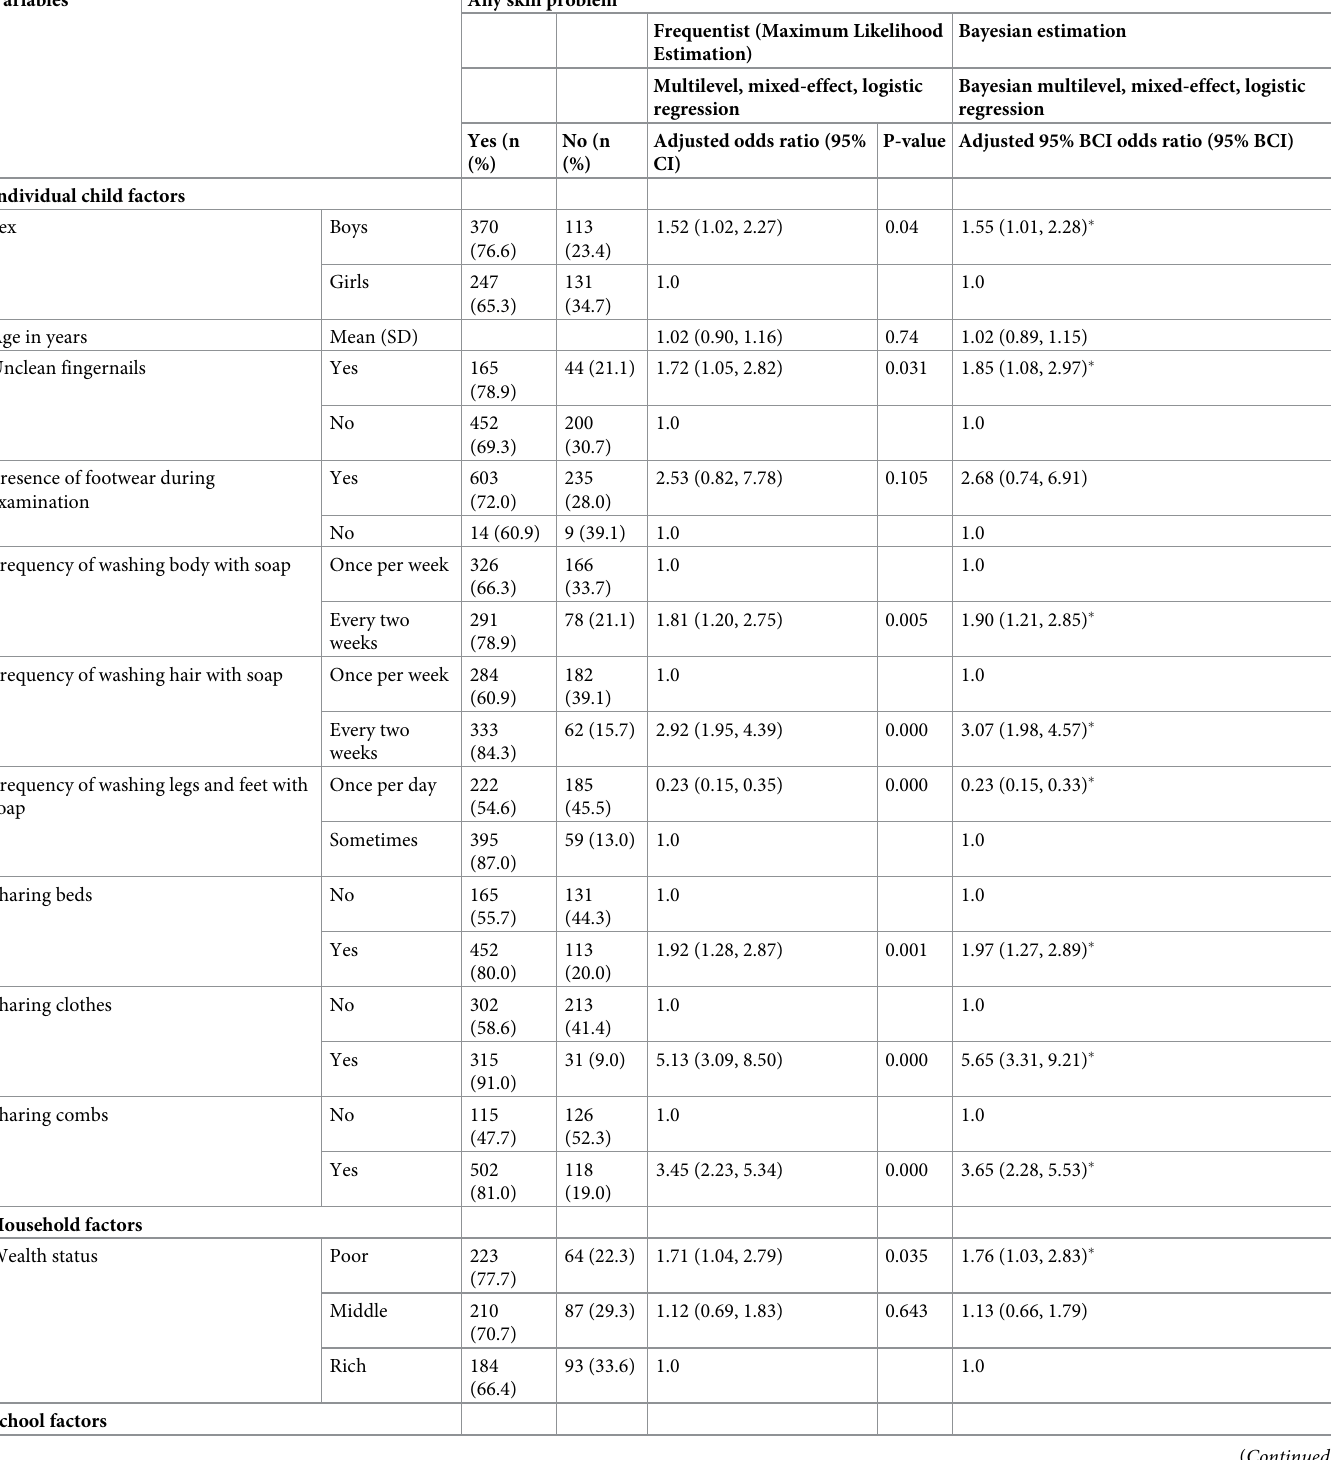
Table 2. Frequentist and Bayesian multivariate, multilevel, mixed-effect, logistic regression analysis of skin problem among schoolchildren in the Wonago district, southern Ethiopia,